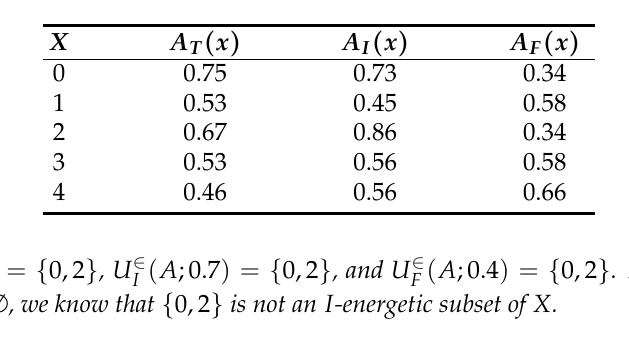
Table 10. Tabulation representation of A = ( A T , A I , A F )